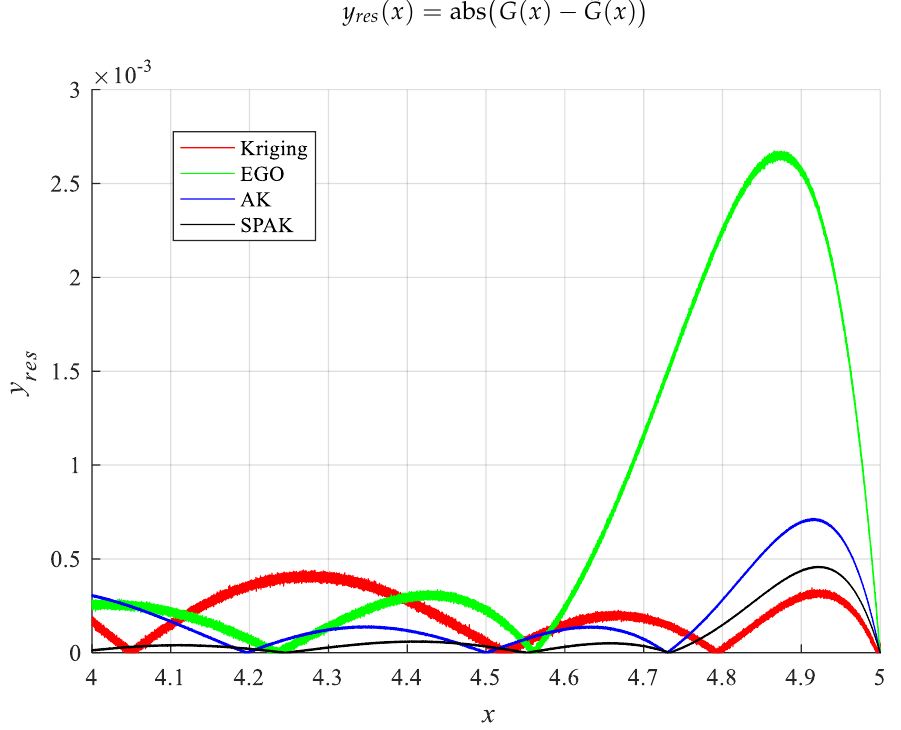
Figure 4. Residual error of different methods in interval x ∈ [4,5].